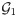
Two example graphs from G1.